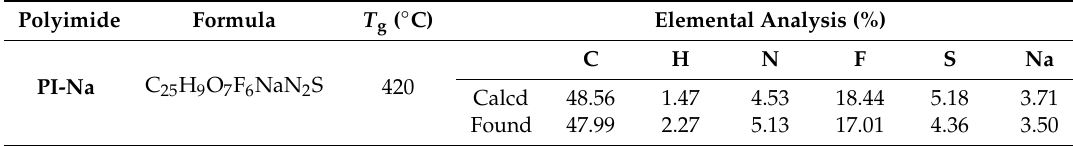
Table 1. Thermal properties and elemental analysis data of the PI-Na .